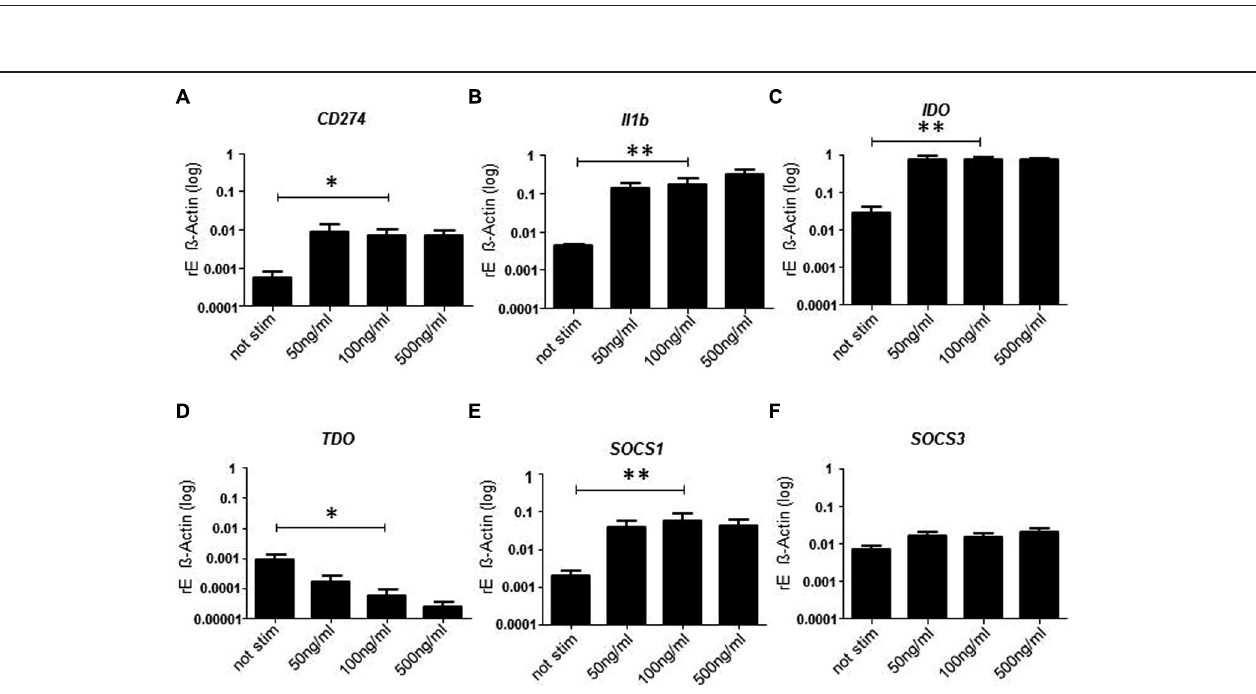
FIGURE 3 | Streptococcal pyrogenic exotoxin A- induced mRNA expression of inhibitory pathways. CD14 + monocytes were stimulated 24 h with increasing concentrations of SPEA. Quantitative real-time PCR of cDNA was performed for (A) CD274, (B) Il1b, (C) IDO, (D) TDO, (E) SOCS1, and (F) SOCS3. Shown is the mean of induction compared to ß-Actin ( ± SD) of 5 donors. Statistical analysis was performed using a Multiple Comparison of Means (Tukey Contrasts). Significance code: 0 ‘ ∗∗∗ ’; 0.001 ‘ ∗∗ ’; 0.01 ‘ ∗ ’.